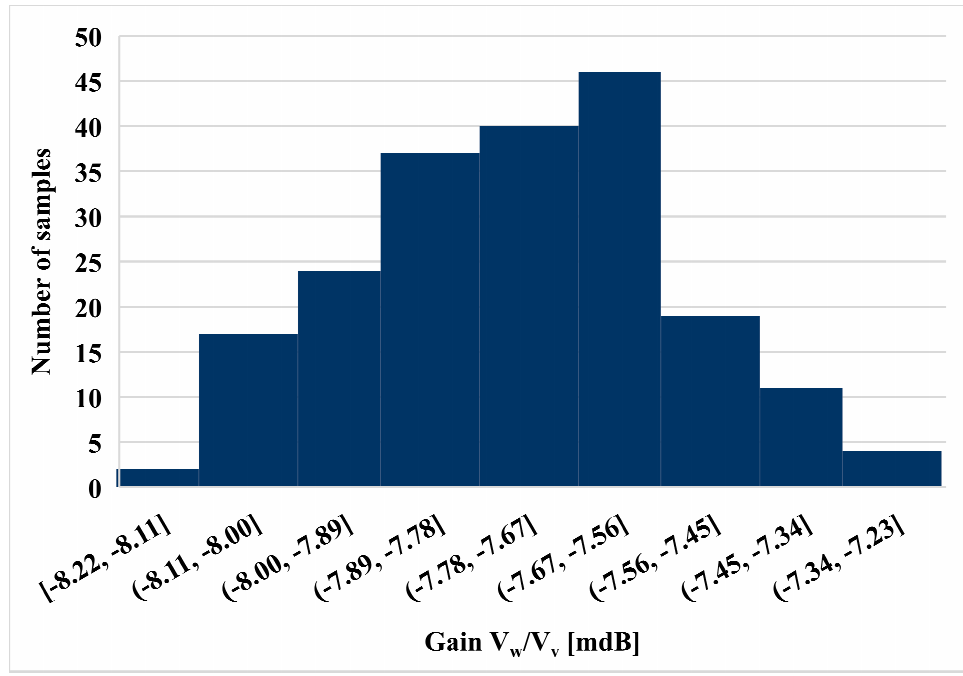
Figure 9. A histogram of the voltage gain V w / V v with 200 runs Monte Carlo (MC) analysis.